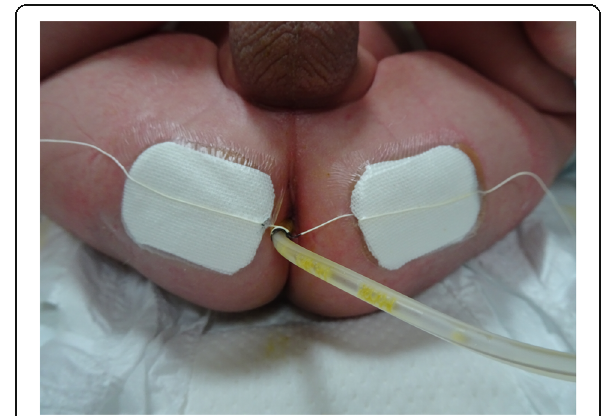
Fig. 2 Contrast enema showing the type of anorectal tube placed in the transverse colon Fig. 3 The tube fixation on the patient ’ s